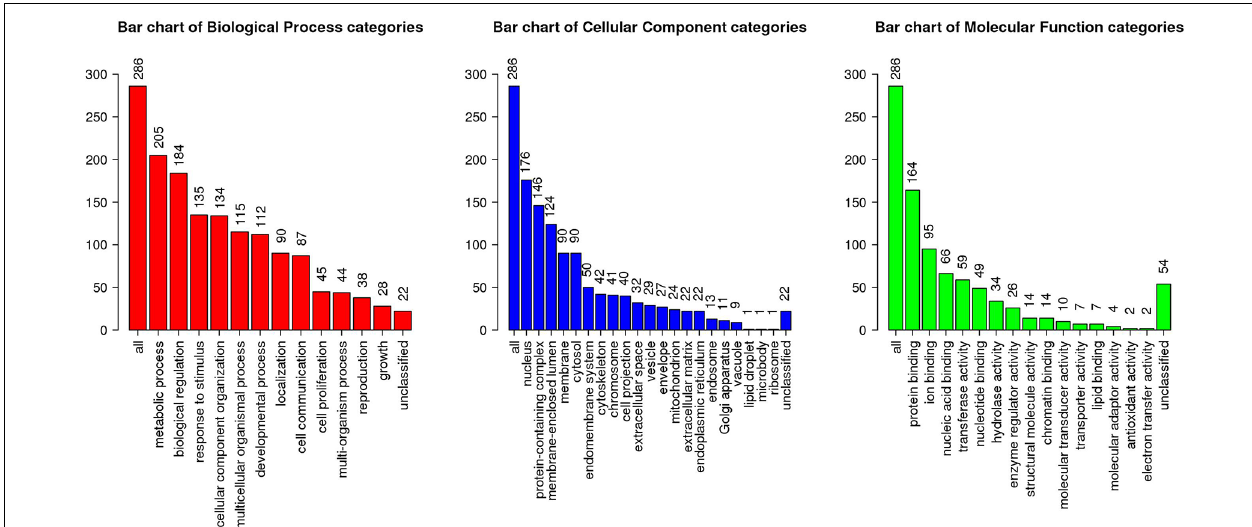
FIGURE 4 | Gene ontology (GO) slim summary of abundance decreased differentially abundant proteins (DAPs) between H − G and N+G treatments. Over-representation analysis (ORA) results of the biological process, cellular component, and molecular function were presented. The heights of the bars represent the numbers of user list genes observed in the